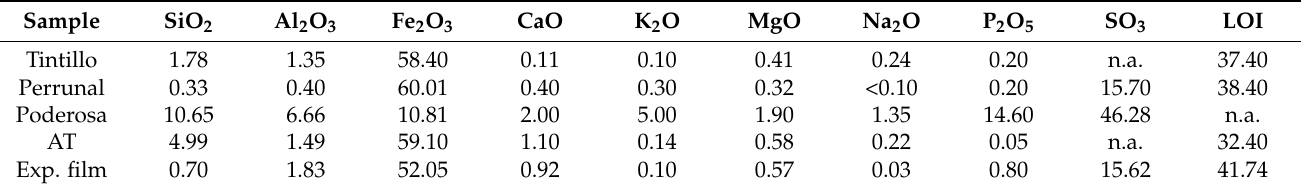
Table 2. Major oxide concentrations (measured with XRF and given in wt.%) of iron-rich floating mineral films found in IPB mine waters. All values refer to single measurements conducted on representative samples from each